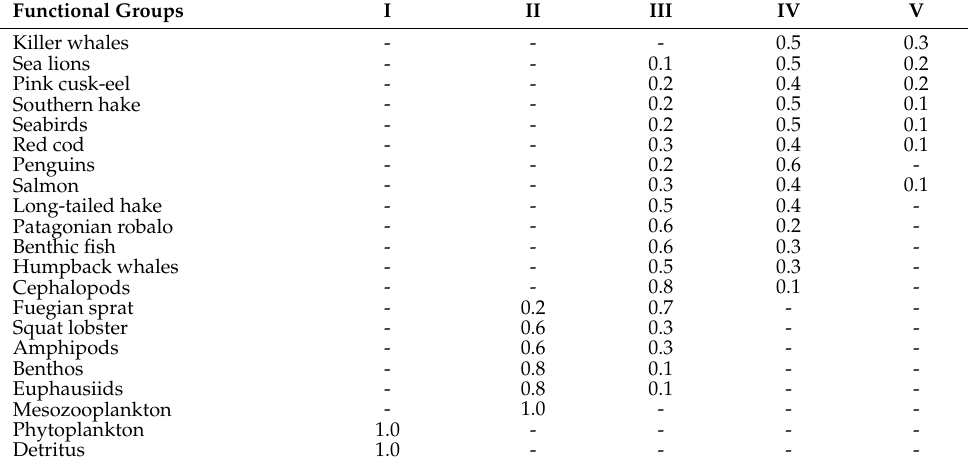
Table 5. Relative fluxes (t km year − 1 ) at each discrete trophic level in the Francisco Coloane Marine Area ecosystem as proposed in [45]. Functional